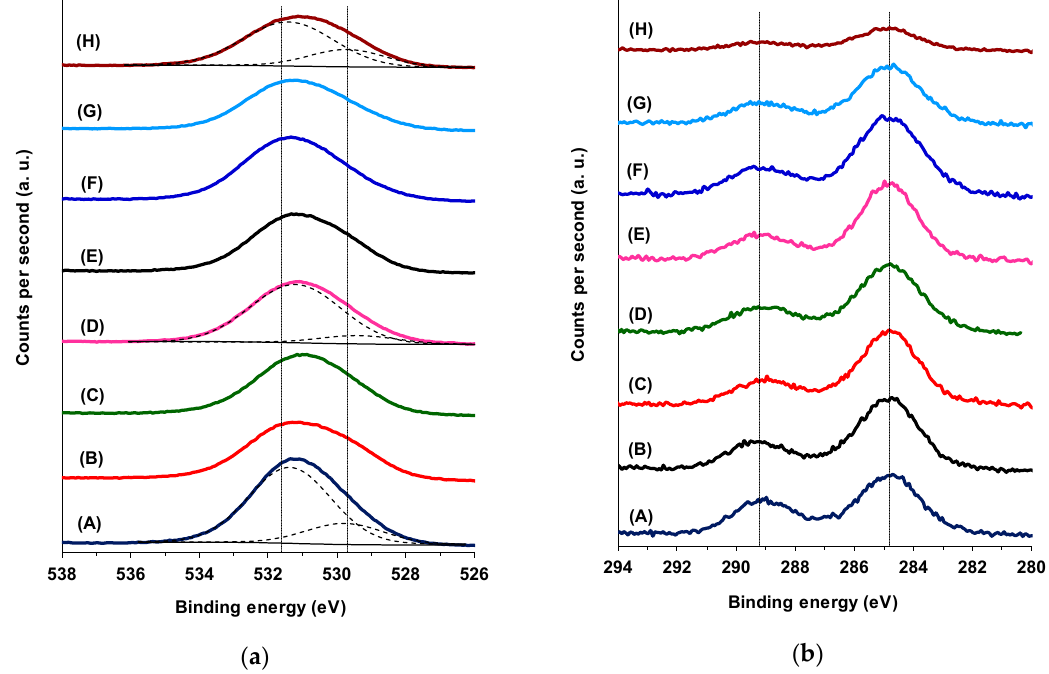
Figure 4. ( a ) O 1s core level and ( b ) C 1s core level XPS spectra of the mixed oxides: CuCeMgAlO (A),